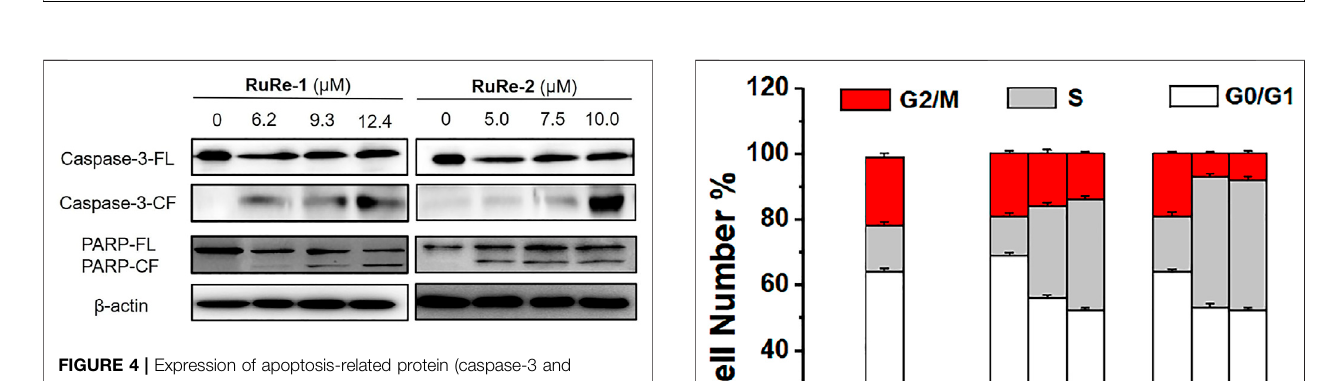
FIGURE 3 | RuRe-1 and RuRe-2 induced HeLa cells apoptosis measured by fl ow cytometry with Annexin V/PI staining. The incubation time of the compounds was 24 h.